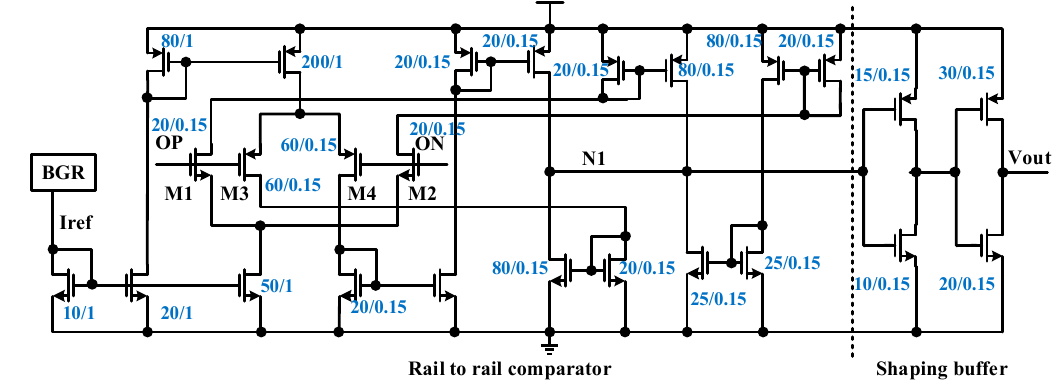
Figure 5. Schematic of the rail-to-rail comparator.